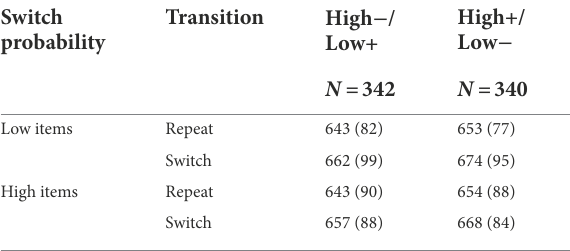
TABLE 5 Mean response times (ms) with standard deviations in Experiment 2 as a function of background valence, switch probability, and